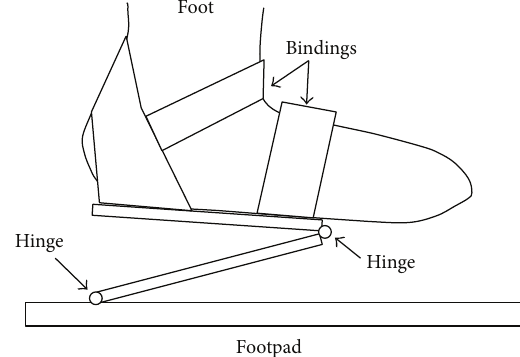
Figure 3: Mechanism of the footpad of the GMmini.